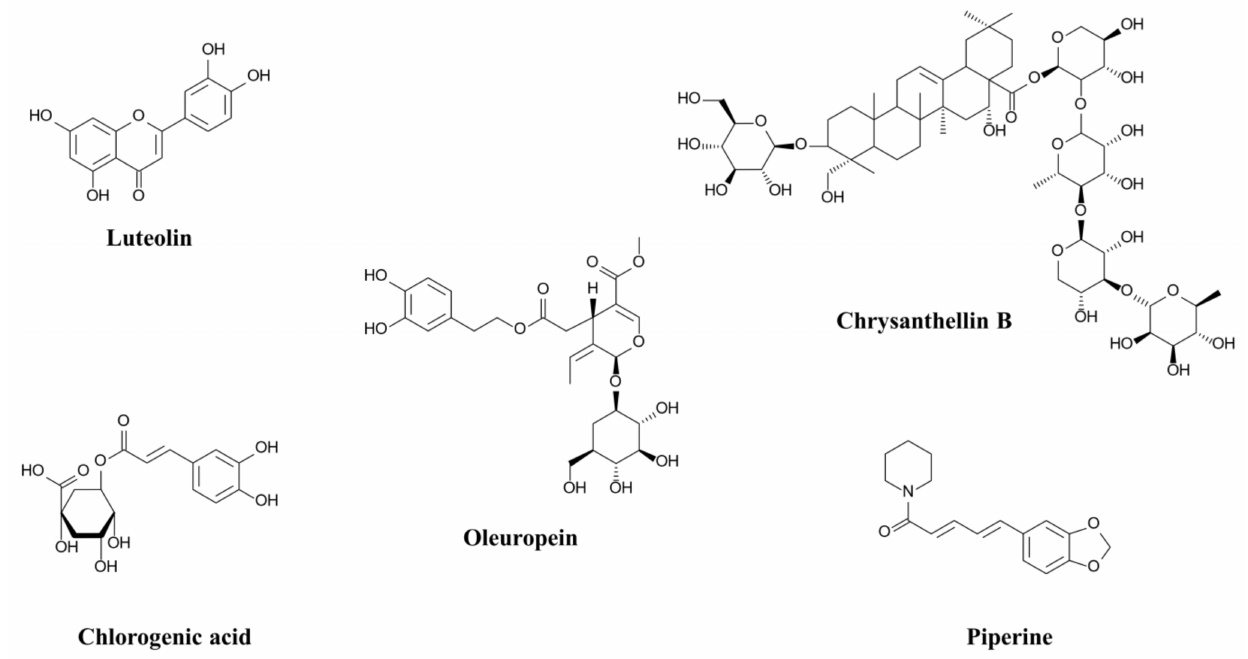
Figure 2. Chemical structures of the compounds tested for α -glucosidase inhibition.